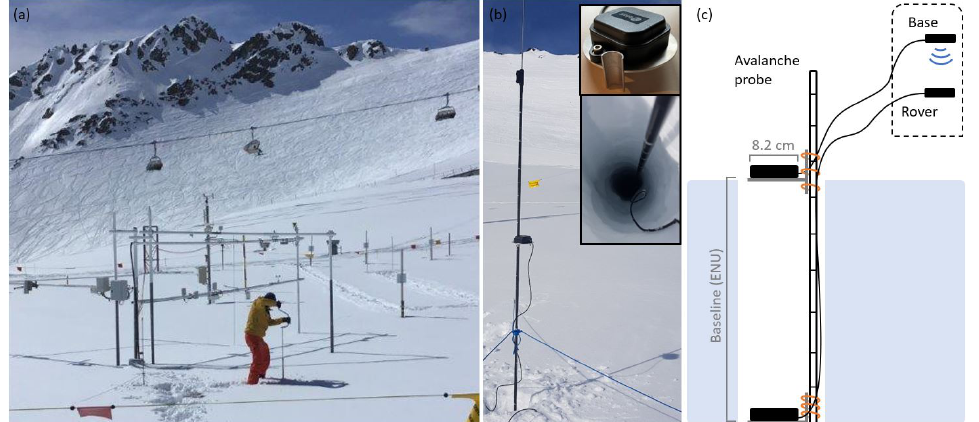
Figure 3. Mobile, low-cost GNSS refractometry snow monitoring system setup at Davos Weiss- fluhjoch: ( a ) drilling a 11.2cm hole in the snowpack; ( b ) system deployed in the field. The base antenna is located above the snow surface, whereas the sub snow antenna is placed on the ground below the snowpack. A string with small anchors fix the system while measuring; ( c ) schematic setup illustrating the GNSS base and rover antennas (u-blox ANN-MB-00) attached to an avalanche probe by cable ties. The true baseline between both antennas can directly be read out by the metric scale on the avalanche probe. The receivers (Emlid Reach M2) are connected to the antennas by cable and can be stored, e.g., in a backpack. The system is configured in RTK GNSS mode where the base data is sent to the rover via the internal